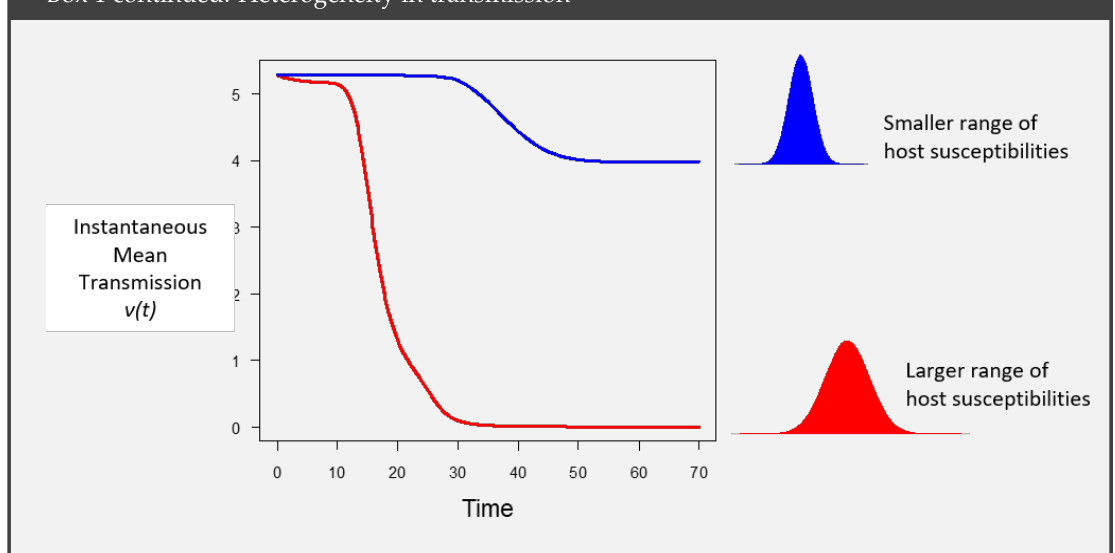
Figure 2. As the epidemic proceeds, the instantaneous mean transmission ν ( t ) drops off as the more susceptible individuals are removed. This decrease is of larger magnitude for a more variable host population (red) than a less variable one (blue).